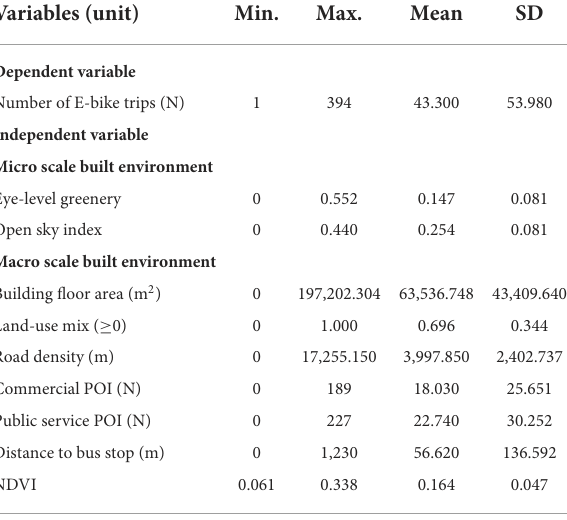
TABLE 2 Statistics for all variables within the Jinan study area, sampled in 2019 (fishnet = 600 × 600m, N = 770). Variables (unit) Min. Max. Mean